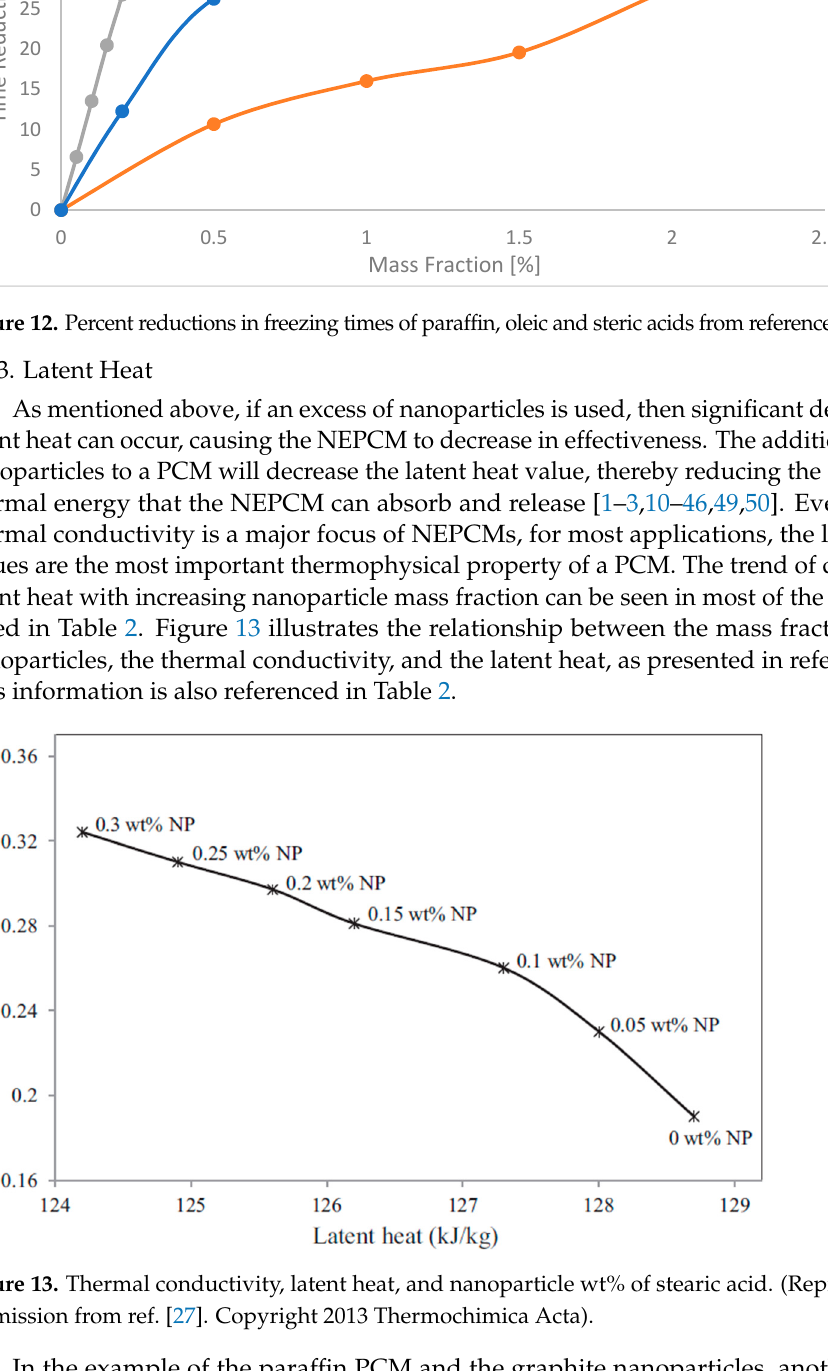
Figure 11. Percent reductions in melting times of paraffin, oleic and steric acids from references